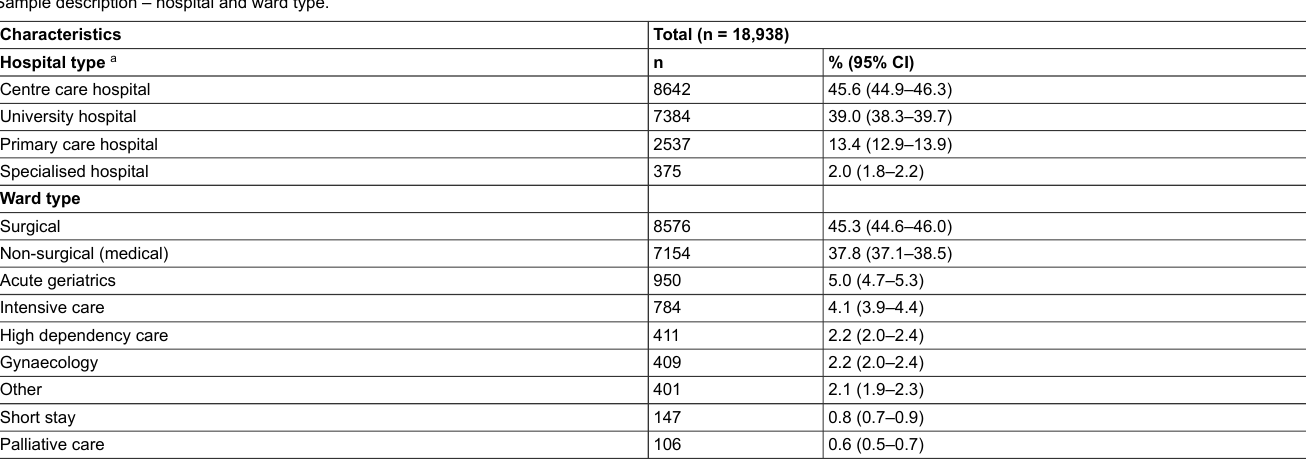
Table S2: Sample description – hospital and ward